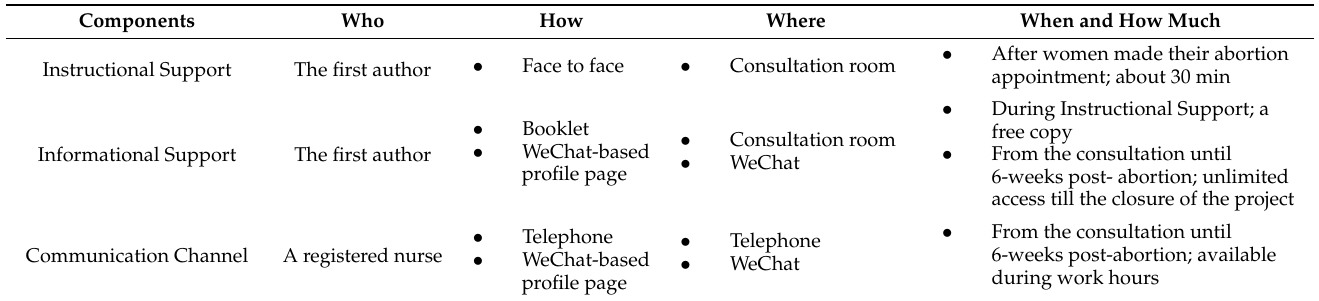
Table 4. The START intervention delivery